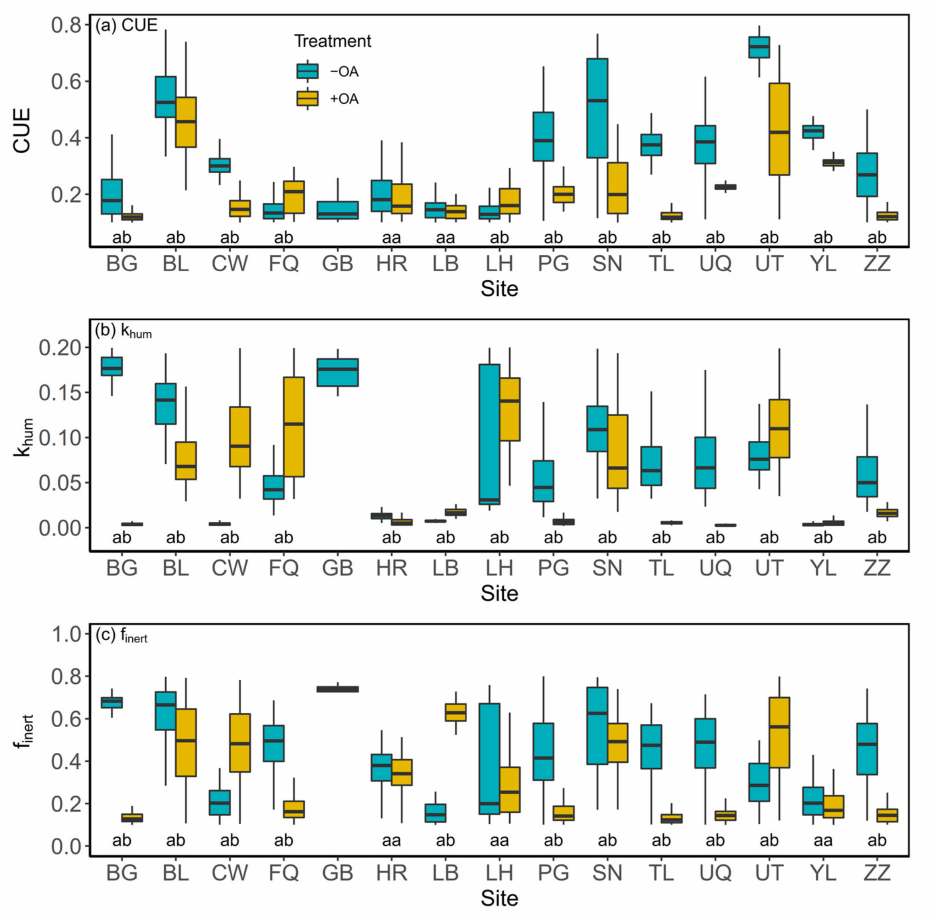
Figure 5. Distribution of CUE ( a ), k hum ( b ), and f inert ( c ) under two OA treatments. CUE, microbial C use efficiency; k hum , the decomposition rate of humic organic carbon; and f inert , the fraction of inert organic C that physically or chemically protected against decomposition. Boxplots show the median and interquartile range, with whiskers extending to the most extreme data point within 1.5 × (75–25%) data range. Lower-case letters under the boxplots show that the difference between the means of parameters under different treatments at each site is significant (ab) or is not significant (aa) at p < 0.05. − OA, without or with less organic amendment; +OA, with or with more organic amendment. See Table 1 for the site